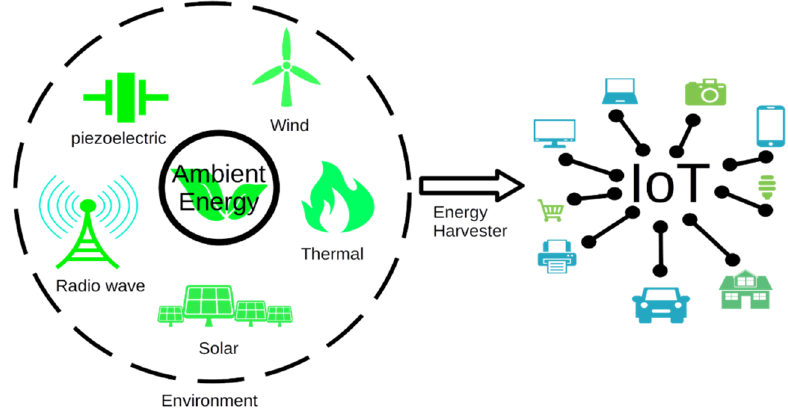
Figure 3. The utilization of the ambient energy in IoT applications.